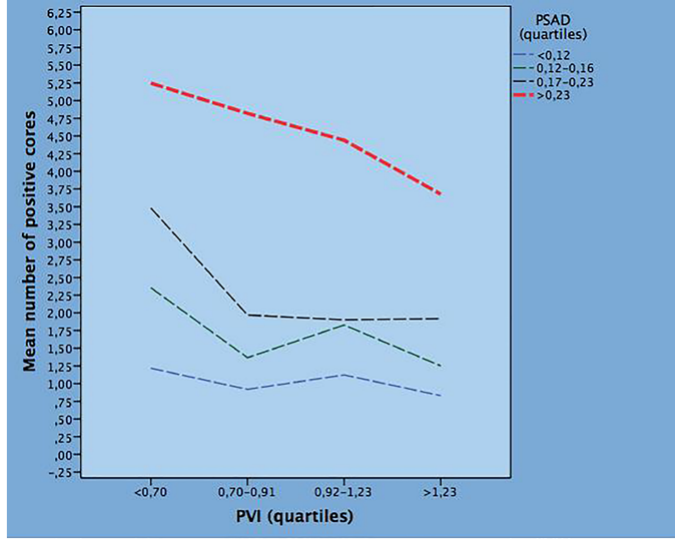
Figure 2 - Bivariate model predicting the mean number of positive cores by prostatic specific antigen density (PSAD) and prostate volume index (PVI) quartiles.